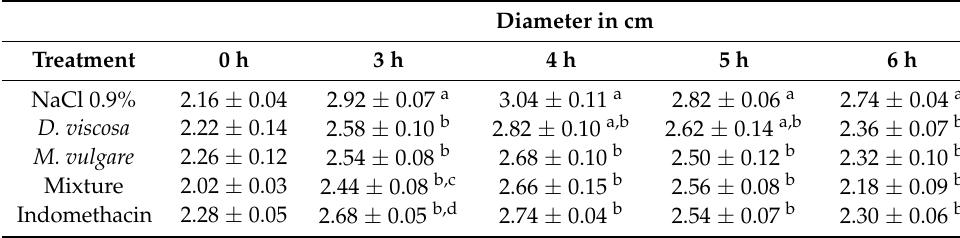
Table 2. Rats paw diameter (cm) of treated groups and the control (NaCl 0.9%) before the injection of carrageenan and at 3 h, 4 h, 5 h, and 6 h after the injection.